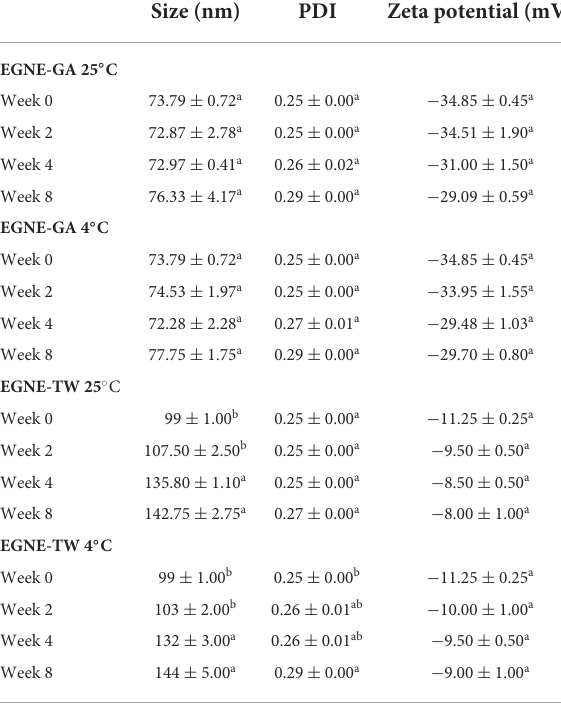
TABLE 2 Droplet size, polydispersity index, and zeta potential of eugenol